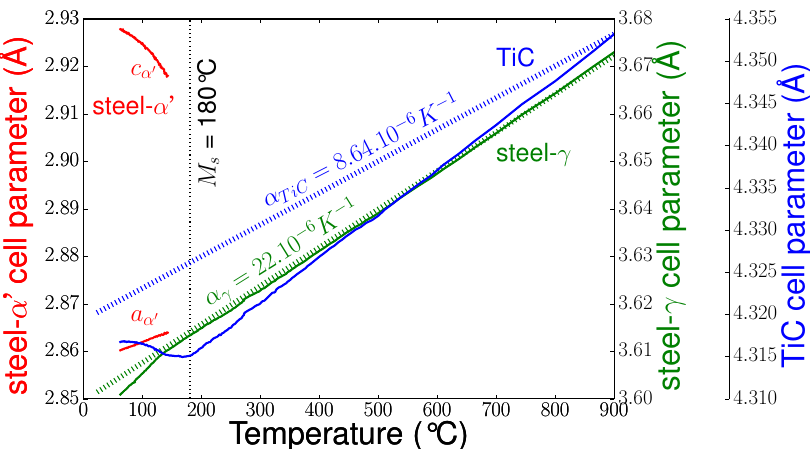
Figure 8. Cell parameter evolutions during cooling (stress-free thermal expansion coefficients of TiC and austenite are also